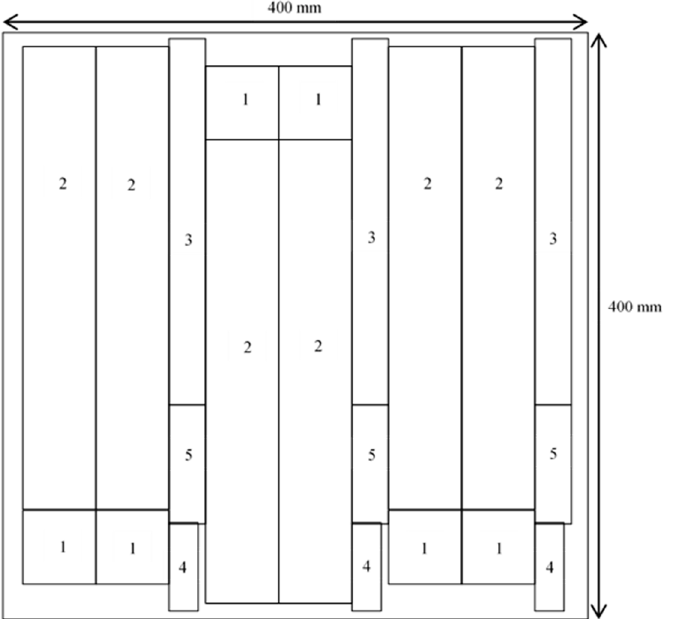
Figure 2. Cutting pattern of specimens for physical and mechanical tests. Note: (1) physical tests such as density, specific gravity, water absorption, radial swelling, longitudinal swelling, tangential swelling and volumetric swelling after two and 24 h; (2) static bending; (3) tensile parallel to the longitudinal axis; (4) compression parallel to the longitudinal axis; (5) gluebond shear test.